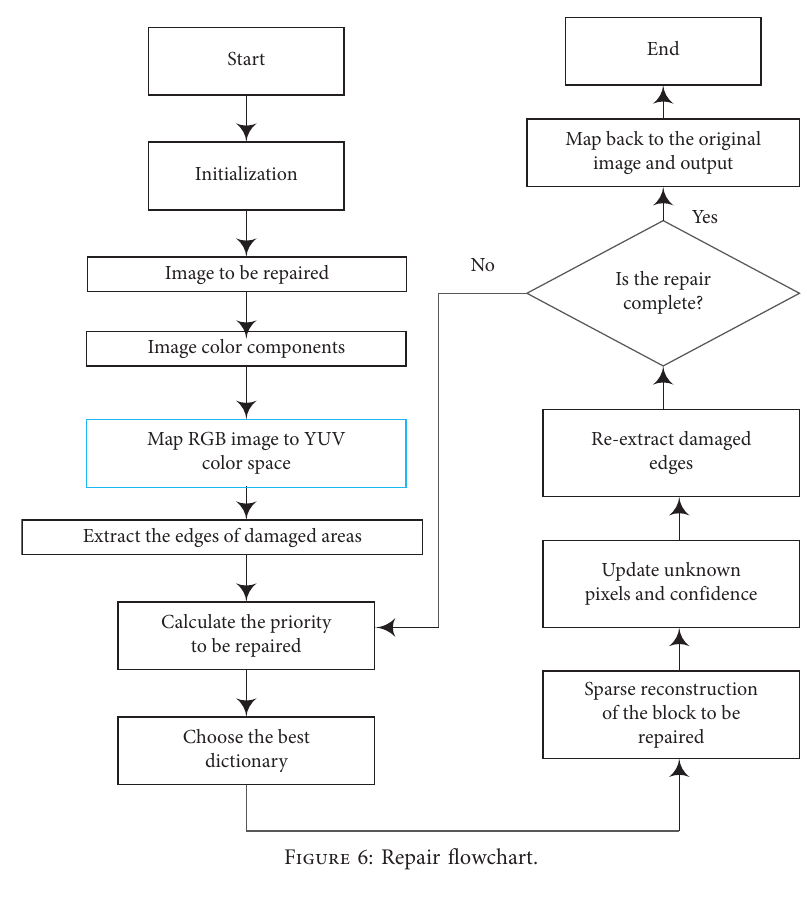
Figure 6: Repair flowchart.